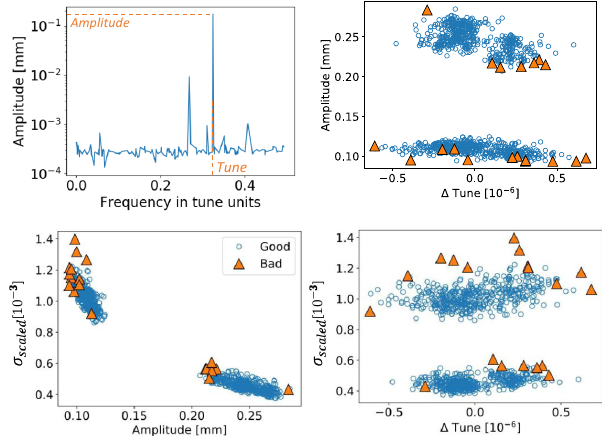
FIG. 2. The upper left plot represents, for a single BPM, the tune and amplitude from harmonic analysis that are used together with noise to amplitude ratio σ as input features for the IF scaled algorithm. 2D projections of the feature space illustrate the detection of bad BPMs.